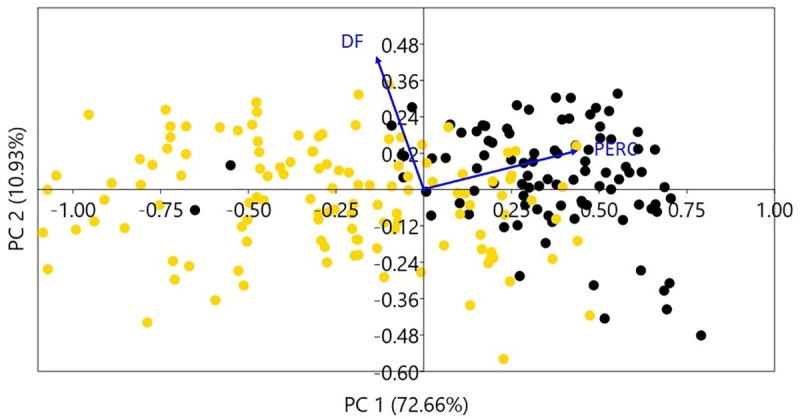
PCA of archaeological and modern cobs for 10 traits.First two PCA axes explain 83.59% of the total variance. Yellow dots represent archaeological cobs. Black dots represent modern cobs. The PC1 axis associated with the perimeter variable separates in two groups: modern and archaeological cobs. PERC = Perimeter of cobs; DF = Feret diameter.